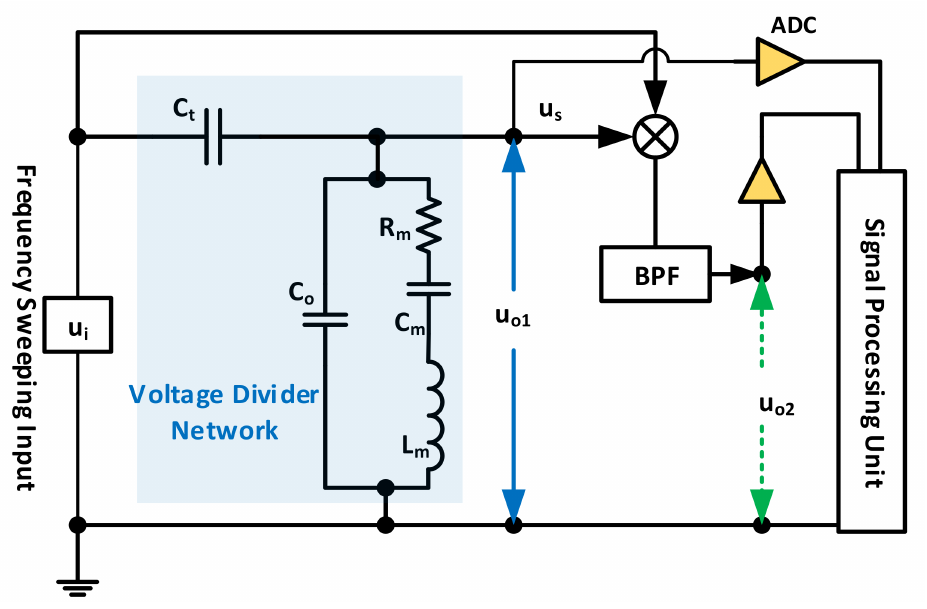
Figure 9. ( Dashed ) Voltage-divider based impedance sweep circuit; ( Overall ) DSB modulated response